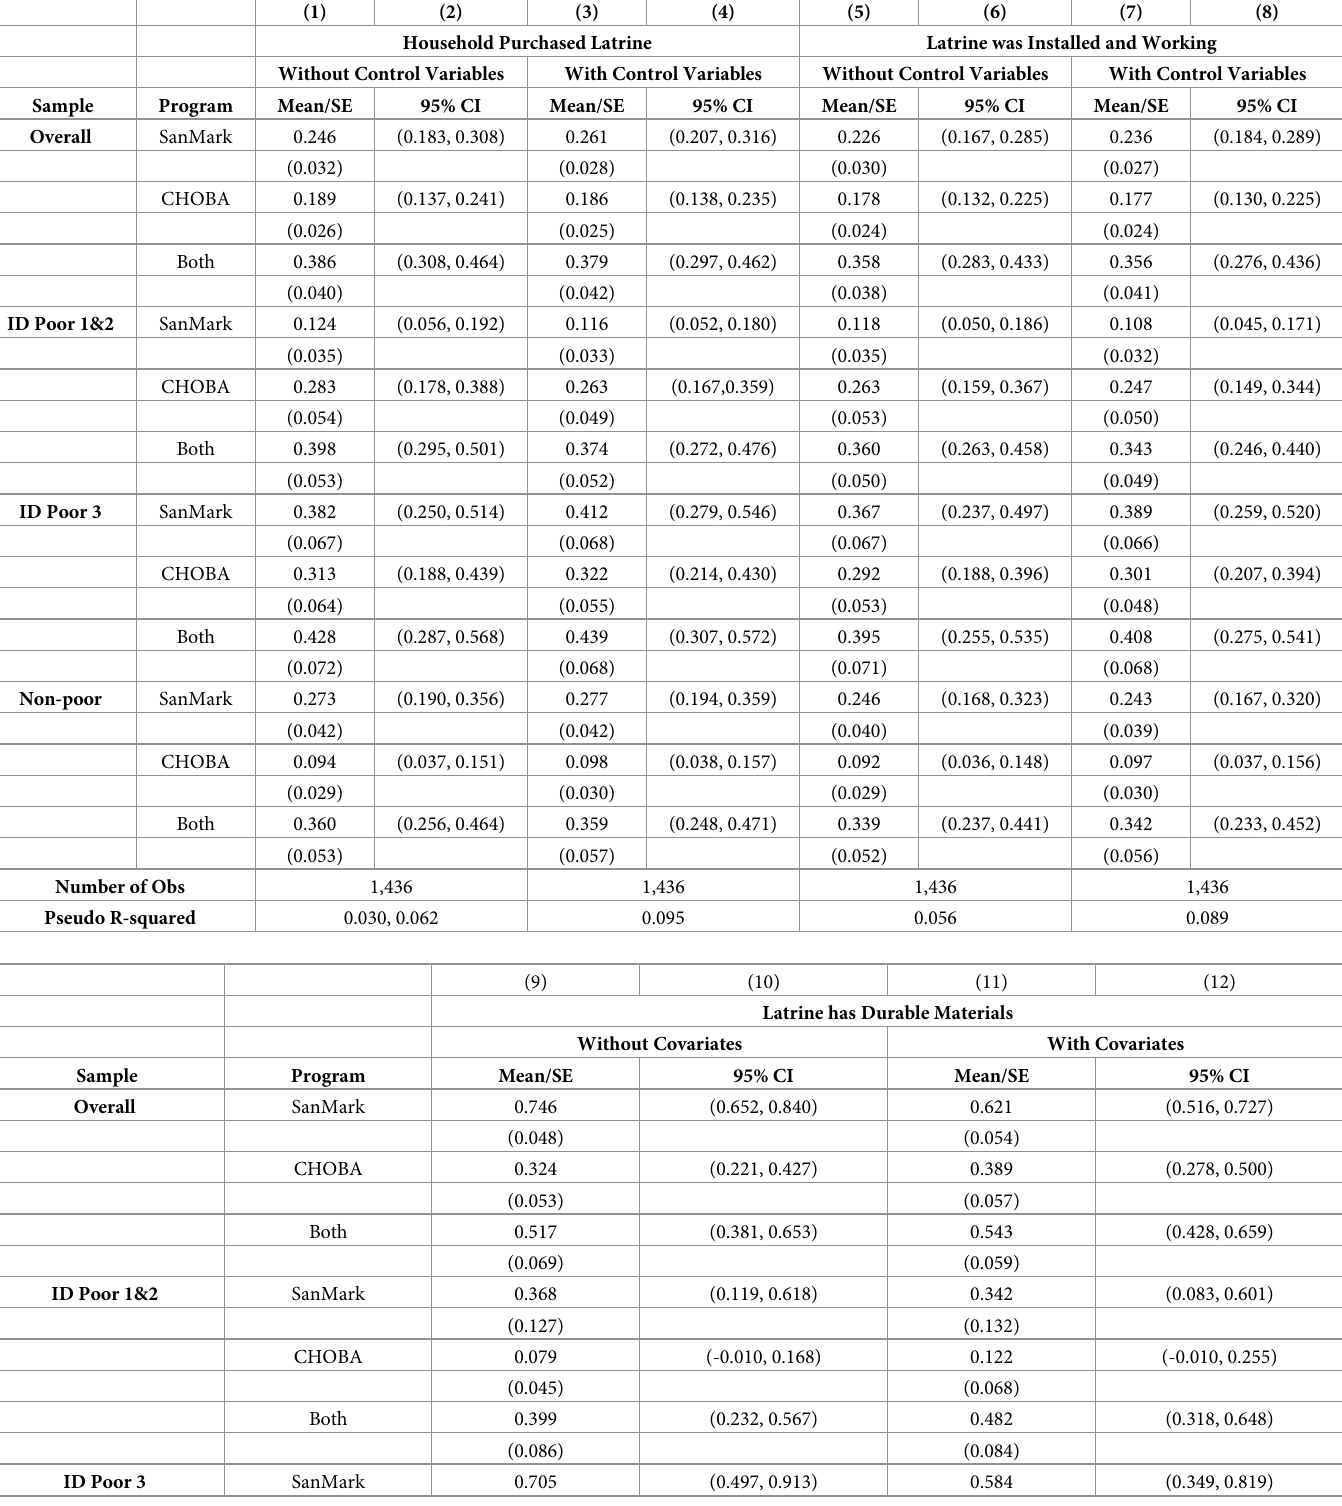
Table 4. Predicted probabilities of outcomes of interest by income groups and village